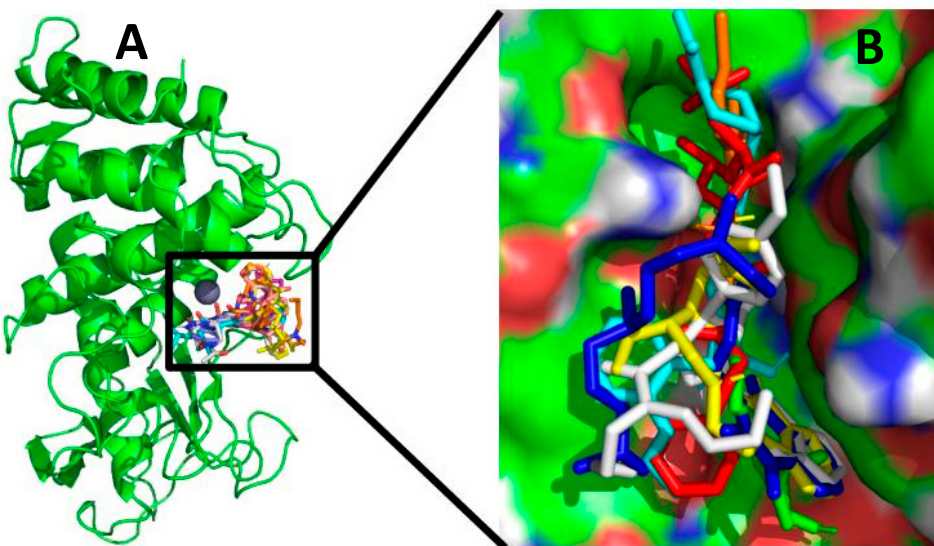
Figure 2. Alignment of the best poses of ligands designed in silico compared to the Lig5H9 reference compound into the thermolysin active site. ( A ) The thermolysin protein in green, the sphere represents the Zn 2+ ion at the thermolysin active site. ( B ) A close-up of the ligands’ best poses in the active site. In red: the reference ligand Lig5H9, green: the Lig783, blue: the Lig1022, yellow: the Lig1392, cyan: the Lig2177, orange: the Lig3444, and white: the Lig6199. Table 1. Calculated docking Δ G binding energies (kcal/mol) and root-mean-square deviation (RMSD) ( Å ) of the firsts ranked Autodock Vina poses of ligand-thermolysin complexes. Docking Pose-1